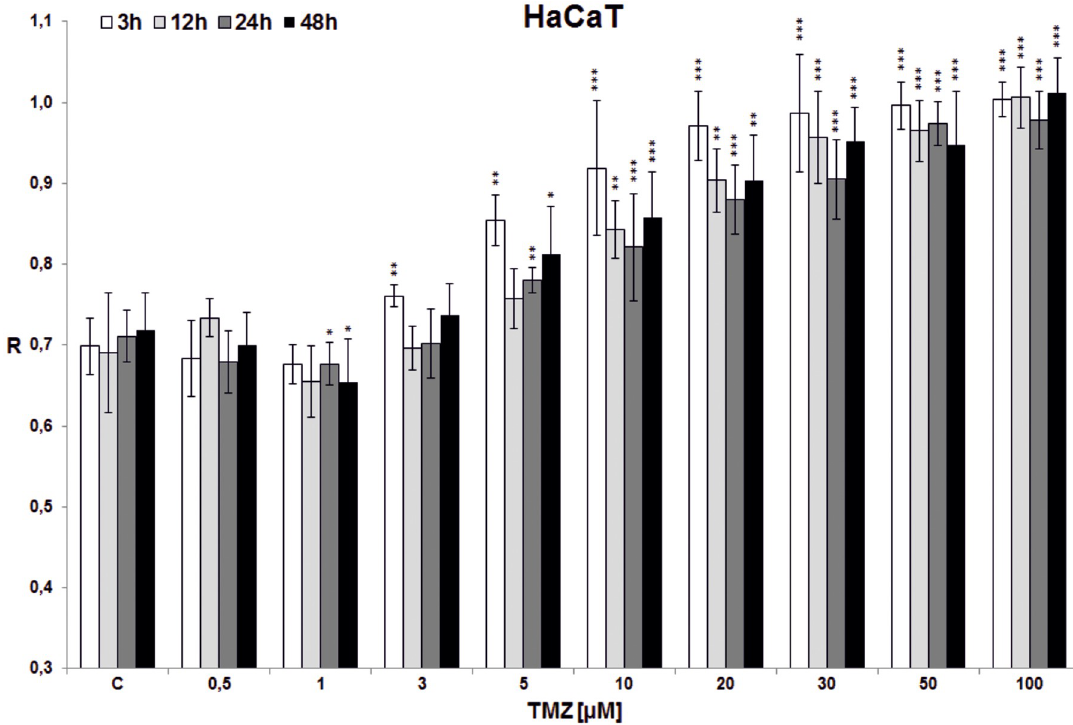
Fig 6. The effect of TMZ on total DNA methylation of HaCaT cell line. The analysis was performed after 3 (white bars), 12 (light grey bars), 24 (dark grey bars) and 48 (black bars) hrs of incubation in a given TMZ concentration (0.5–100 μ M). Control cells (C) were treated with DMSO only. The R values are means from three experiments ± SD. Asterisks indicate a significant difference ( � p < 0,05, �� p < 0,01, ��� p < 0,001) from the control (DMSO) value. In all incubation times the hypermethylation effect is seen over TMZ concentration of 5 μ M. No hypomethylation in lower concentrations was